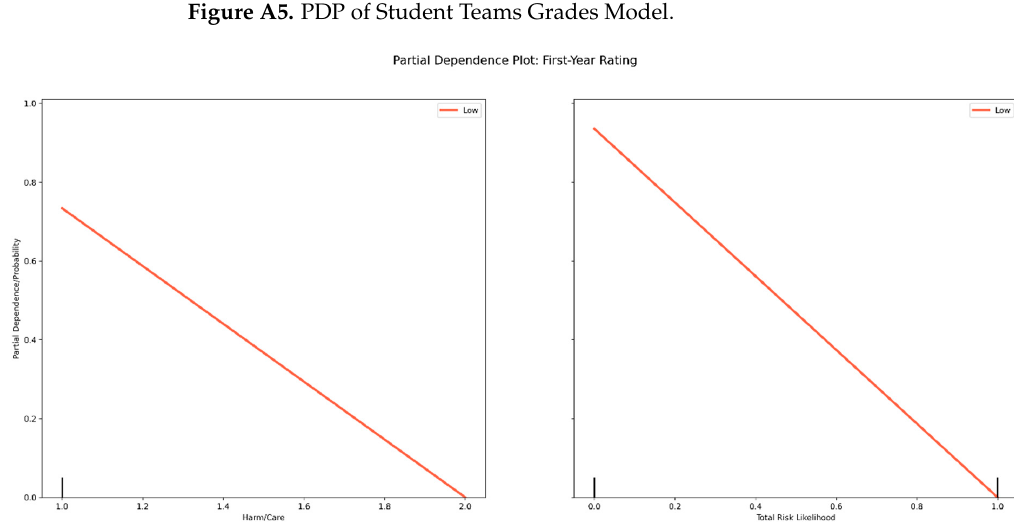
Figure A6. PDP of First–Year Rating Model.